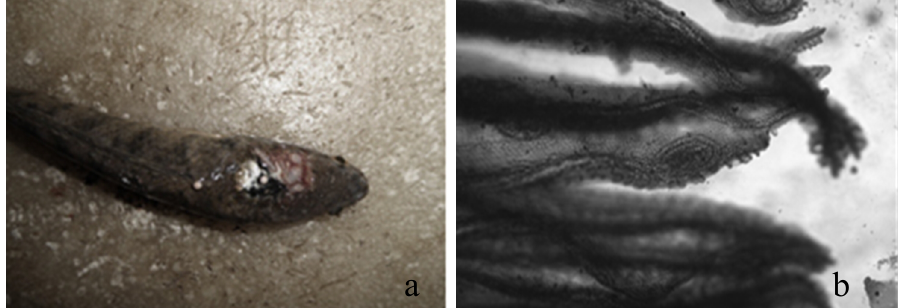
Figure 2. Infected fish ( Channa sp.) (a) and immature stage of Gyrodactylus sp. attached with its gills